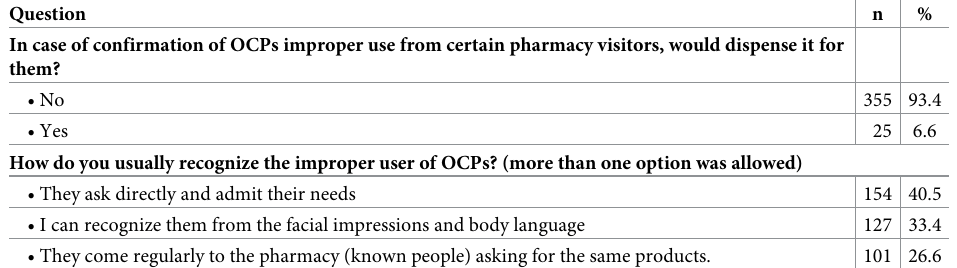
Table 3. Pharmacist attitude and behavior towards OCPs improper use (n = 380). Question n